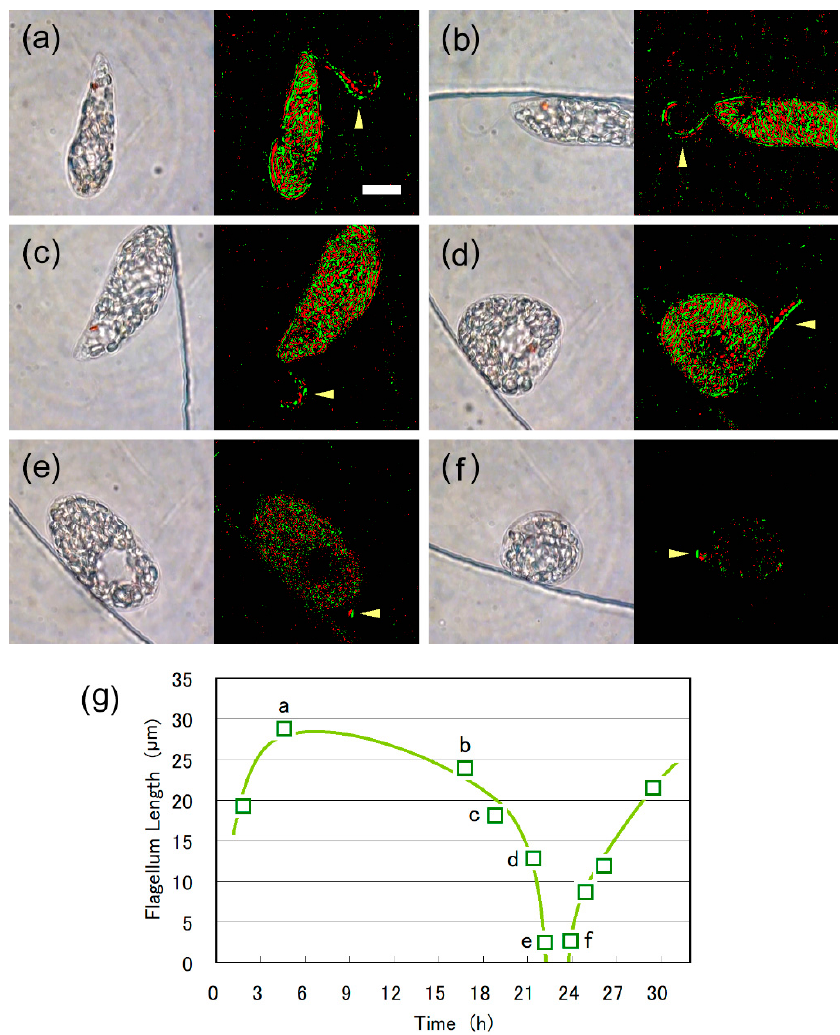
Figure 6. Shortening of the emergent flagellum, as seen in the images extracted from the video recording ( left panels) and enhanced images ( right panels) of the Figure 5 case. Enhanced images were obtained with differentiation and binarization of two images at 61 ms intervals. The length of the emergent flagellum was ( a ) 29 μ m at 4.57 h, ( b ) 24 μ m at 16.78 h, ( c ) 18 μ m at 18.83 h, ( d ) 13 μ m at 21.41 h, ( e ) 2.5 μ m at 22.18 h. ( f ) After the cell division, the emergent flagellum (2.6 μ m in length) was first observed for one of the daughter cells at 23.91 h. Scale bar, 10 μ m. ( g ) Temporal change in flagellum length. The graphical line is provided to indicate the trend.